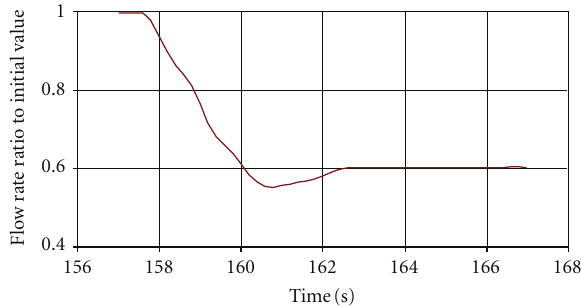
Figure 10: Transient flow rate behavior in the FR test.